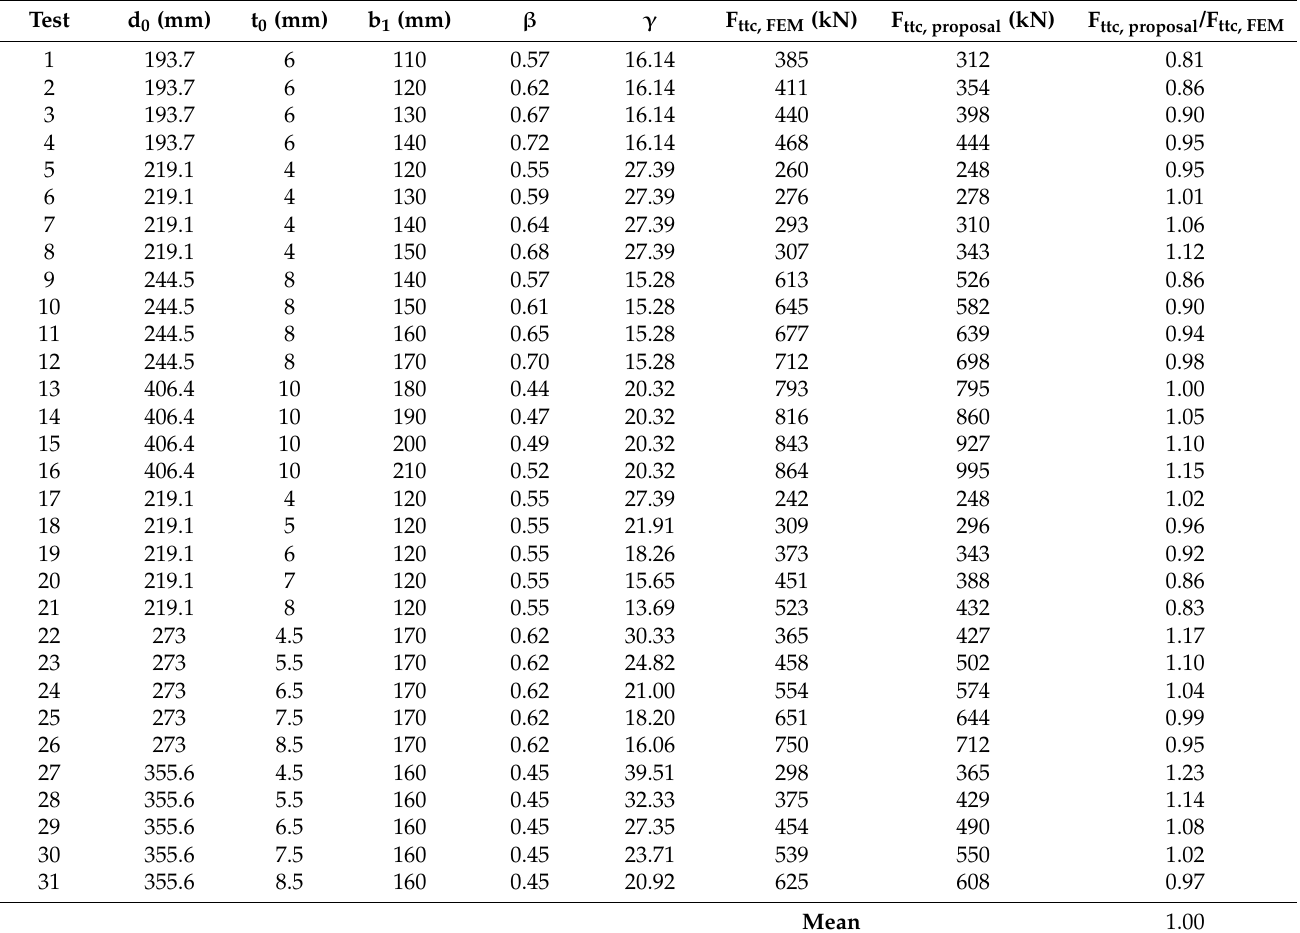
Table 3. Validation of the proposed formulation related to the strength in